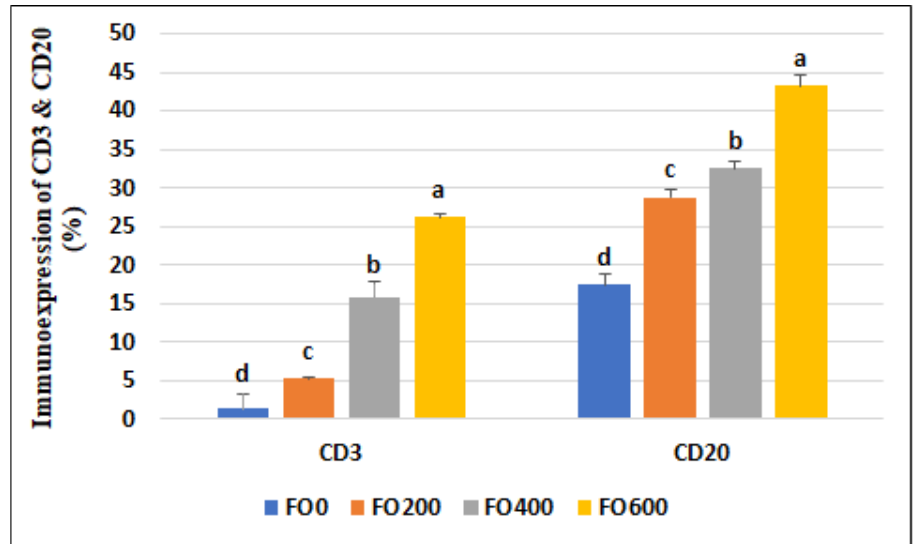
Figure 3. Morphometric analyses of immunostained CD3 and CD20 cells in the spleen of broilers from different experimental groups. Means with different superscripts ( a,b,c,d ) are significant at p < 0.05.